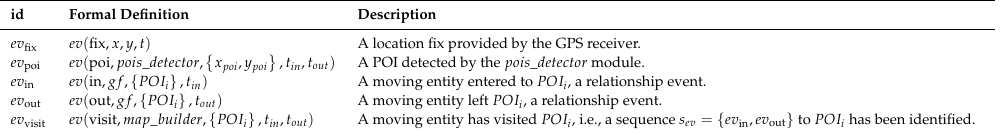
Table 3. Events of interest for mobility analysis based on POIs and their relationships.